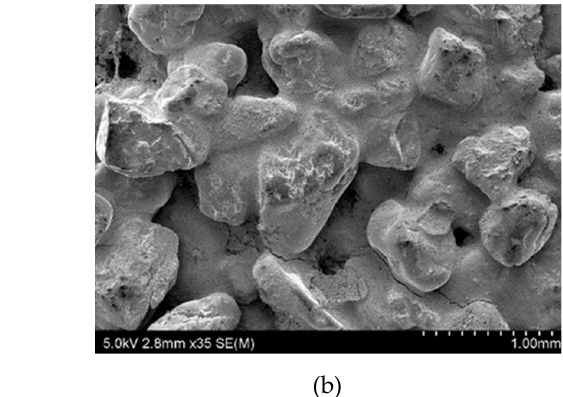
Figure 10. SEM morphology of the ceramic mold samples heated to 950 °C for: ( a ) Sample Q1 and ( b ) Sample Q2.